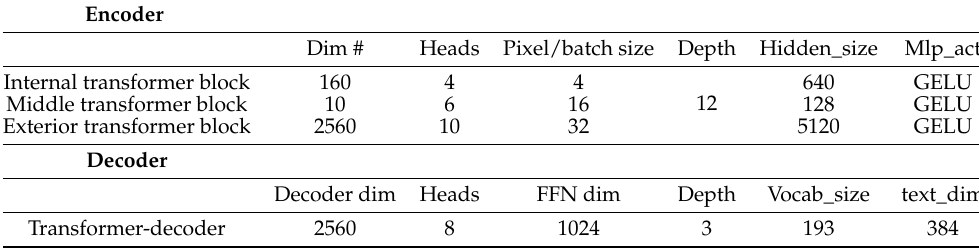
Figure 4. Patch embedding and Pixel embedding position encodings. Table 1. Strategies used in the training